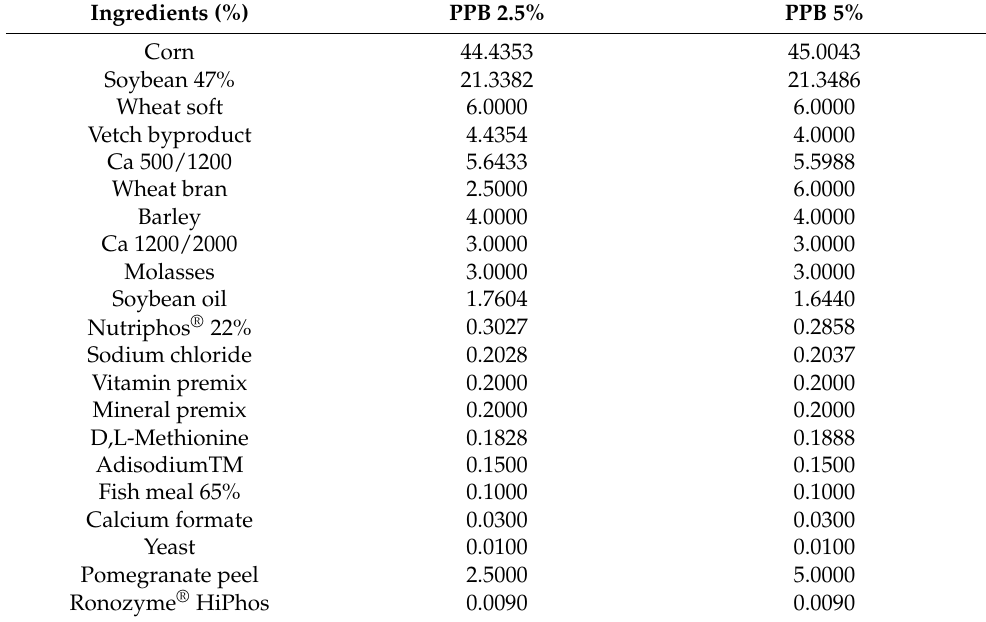
Table 1. Main ingredients of diets. Diets T2 and T4 contained Ronozyme ® WX 100 g/t.